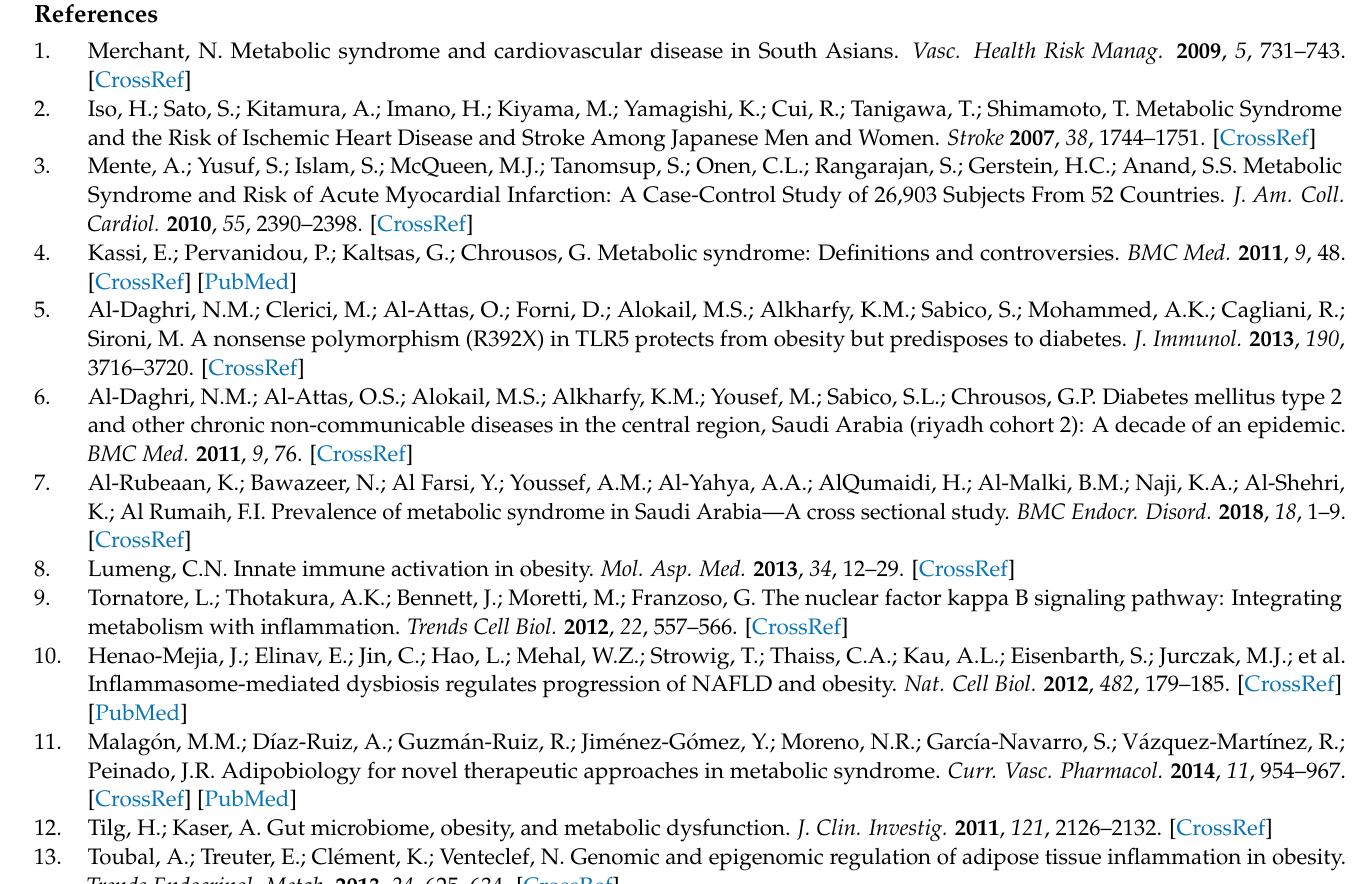
Table S2: Correlation of TTP with other